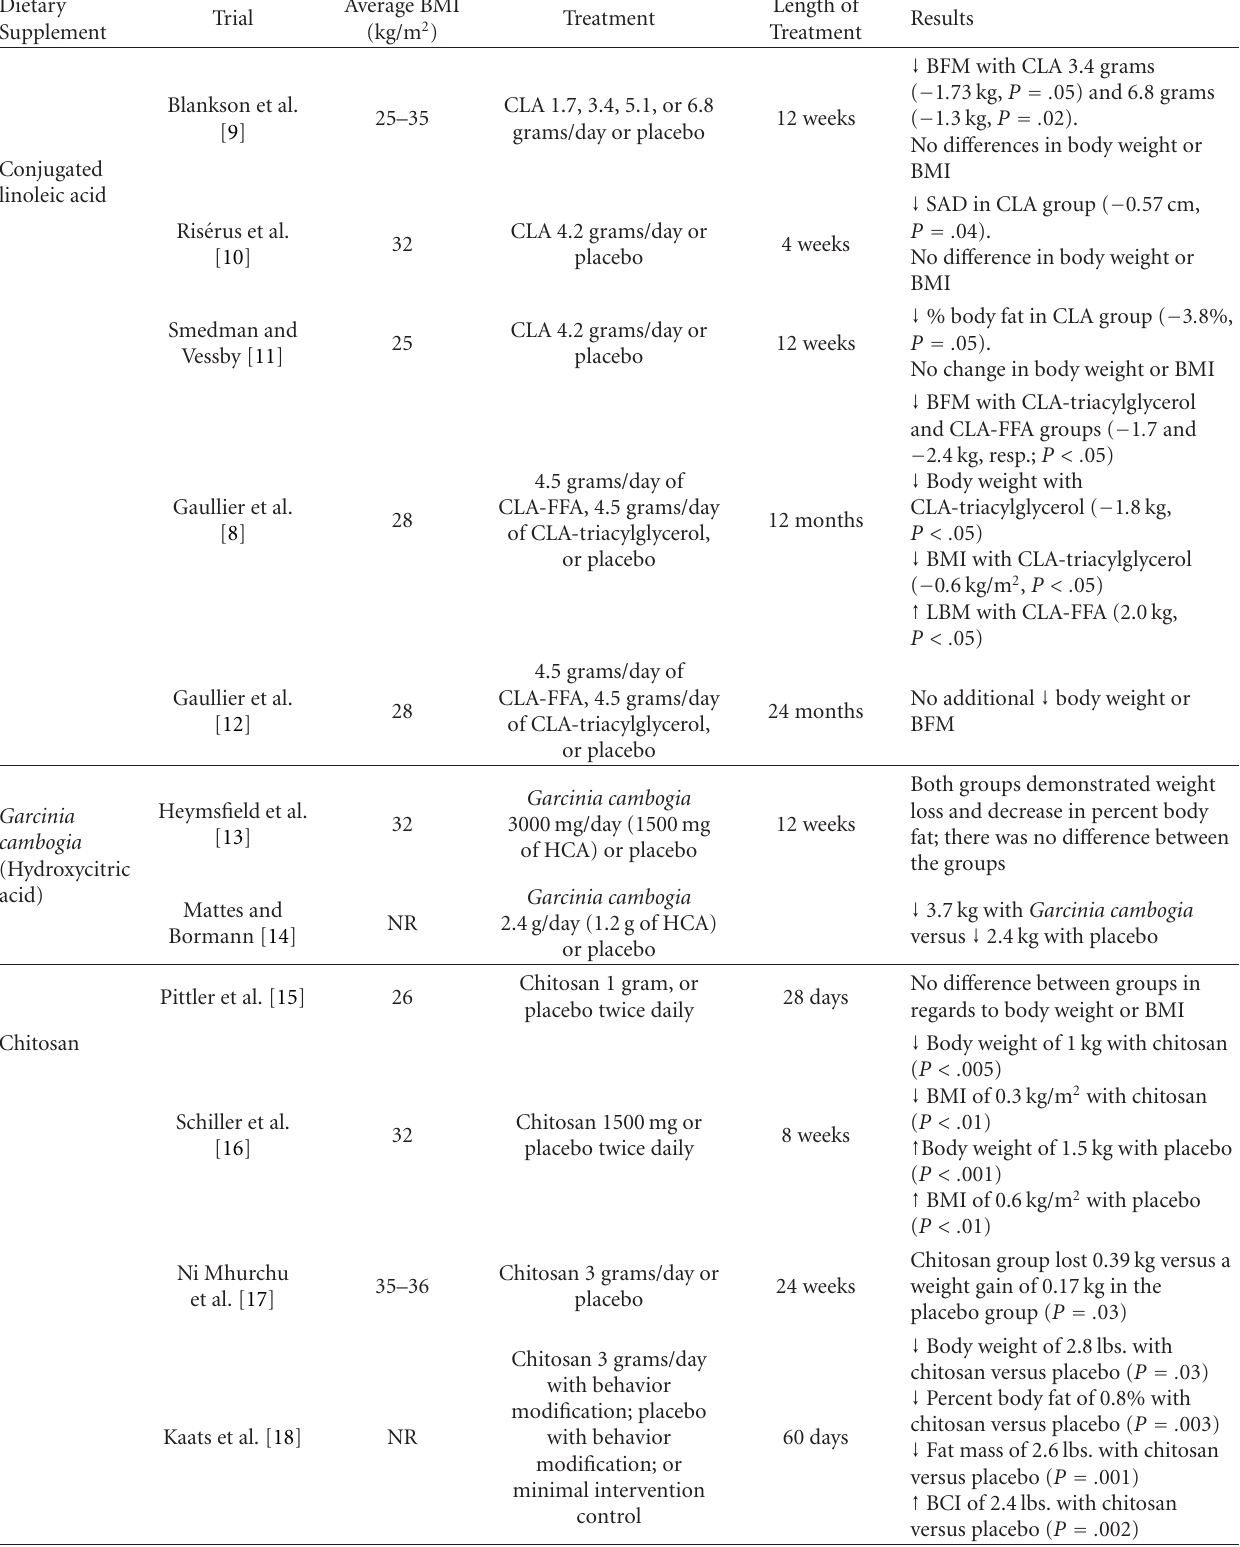
Table 1: Summary data of fat modifying supplemental weight loss